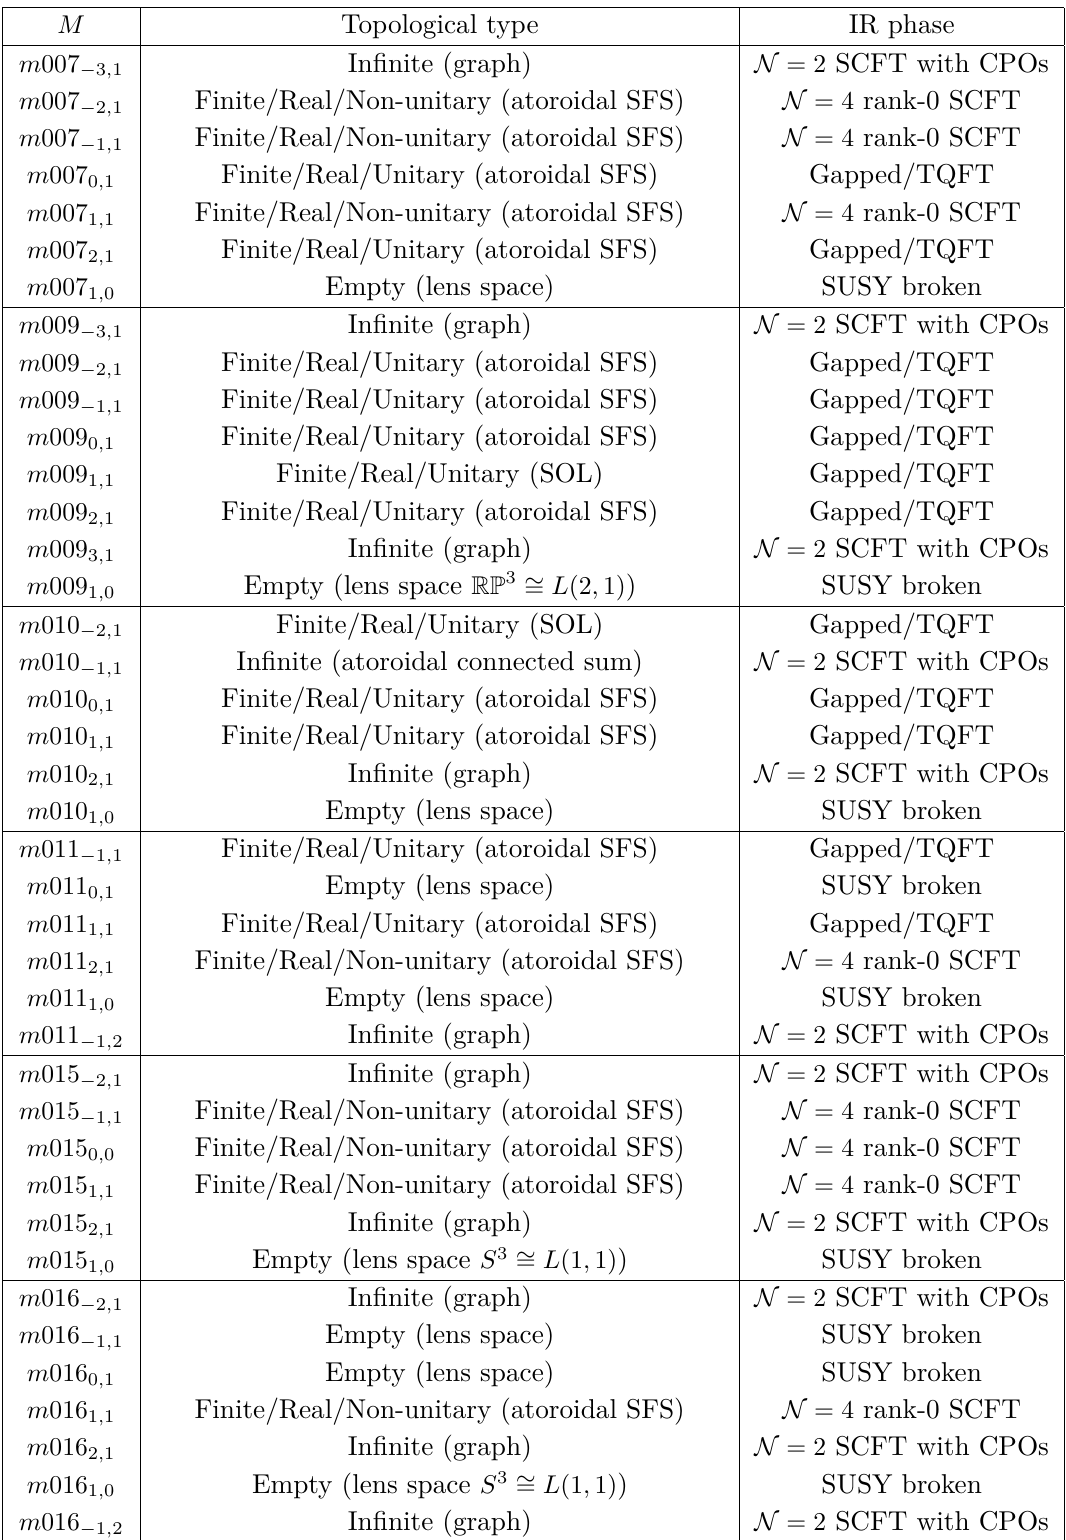
Table 3. Topological types of non-hyperbolic 3-manifolds obtained by exceptional Dehn fillings and the IR phases for the associated class R theories. Here N . Refer to [8] for the topological types of the non-hyperbolic 3-manifolds in the N PA SP + QB SP conventional mathematical classification scheme ( continues